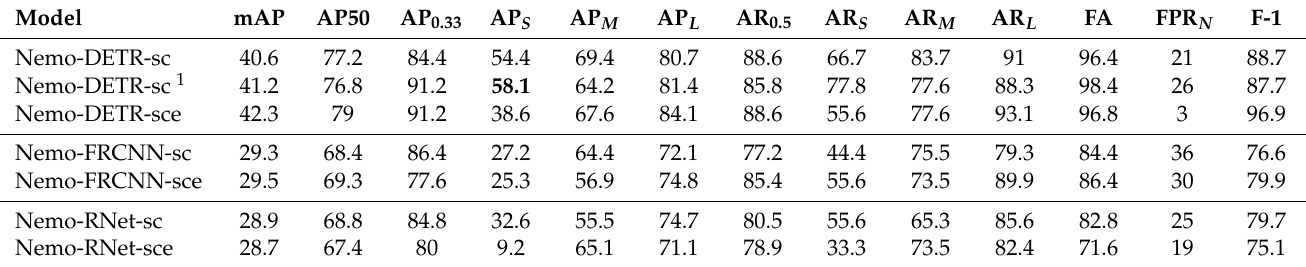
Table 6. Wildfire smoke detection results. Three different models, DETR, FRCNN, and RetinaNet (RNet) were trained with our dataset (Nemo) using the two data configurations from Table 2 (sc and sce).